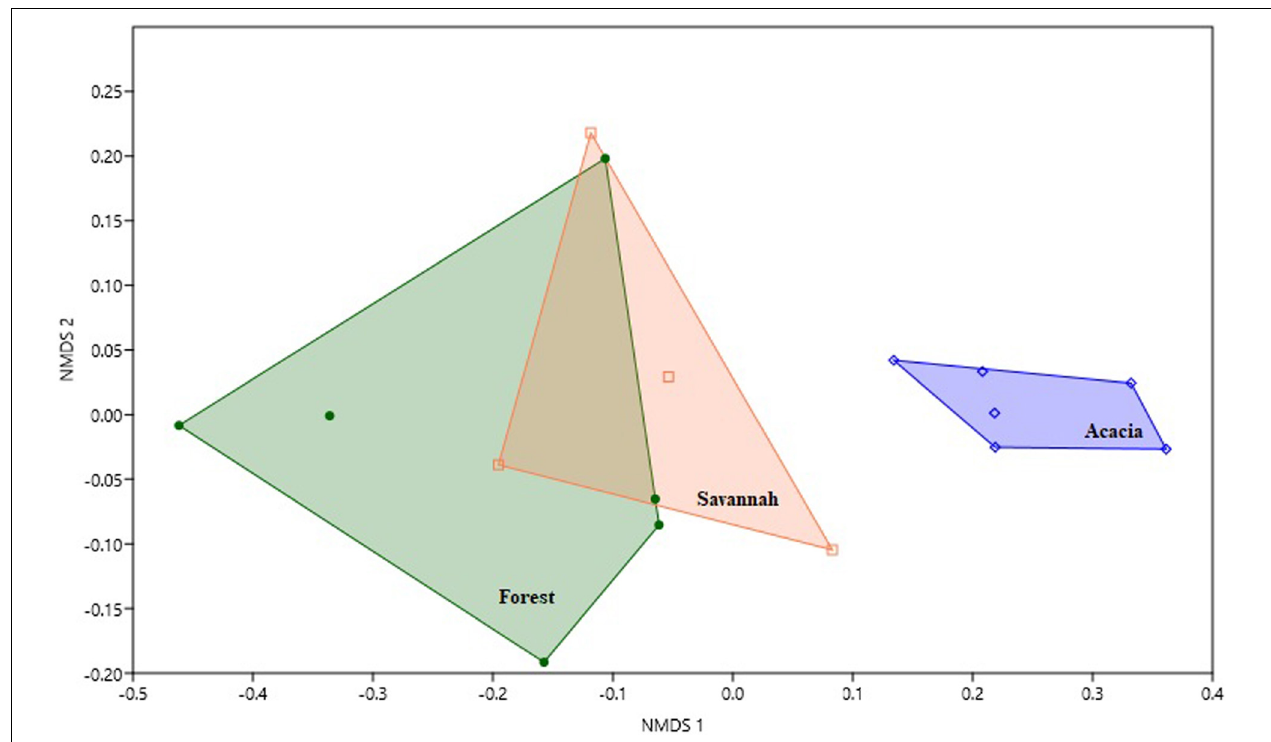
FIGURE 2 | Non-metric multidimensional scaling (NMDS) ordination plot displaying the differences in bat species composition between the forest, savannah, and acacia plantations in an area of Amazonian savannah in the northern Brazilian Amazon. The NMDS was performed on a Bray-Curtis similarity